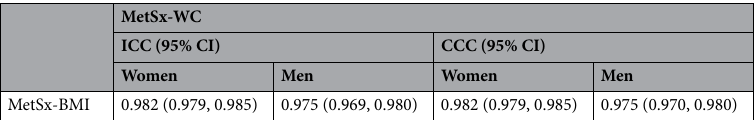
Table 7. Concordance and intraclass correlation coefficients between MetSx-WC and MetSx-BMI. ICC intraclass correlation coefficient, CCC concordance correlation coefficient, CI confidence interval.